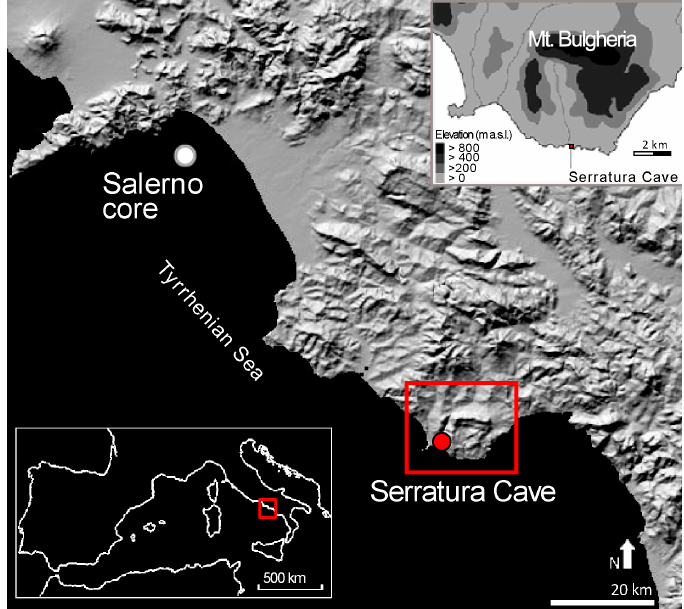
Figure 1. Geographical position of the Serratura Cave on the coast of Cilento (southern Italy, 40°00 ′ N; 15°22 ′ E).